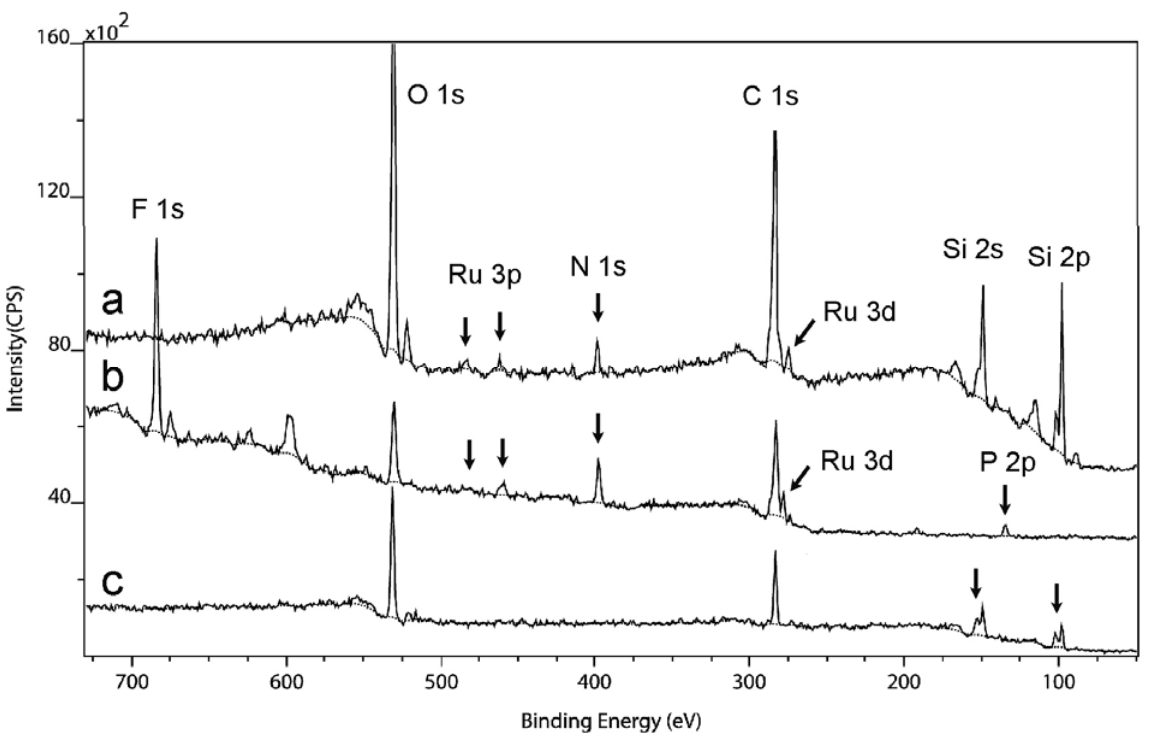
substrate (top curve) and an OTS covered SiO substrate 2 2 ) - as the counter ions, is also 6